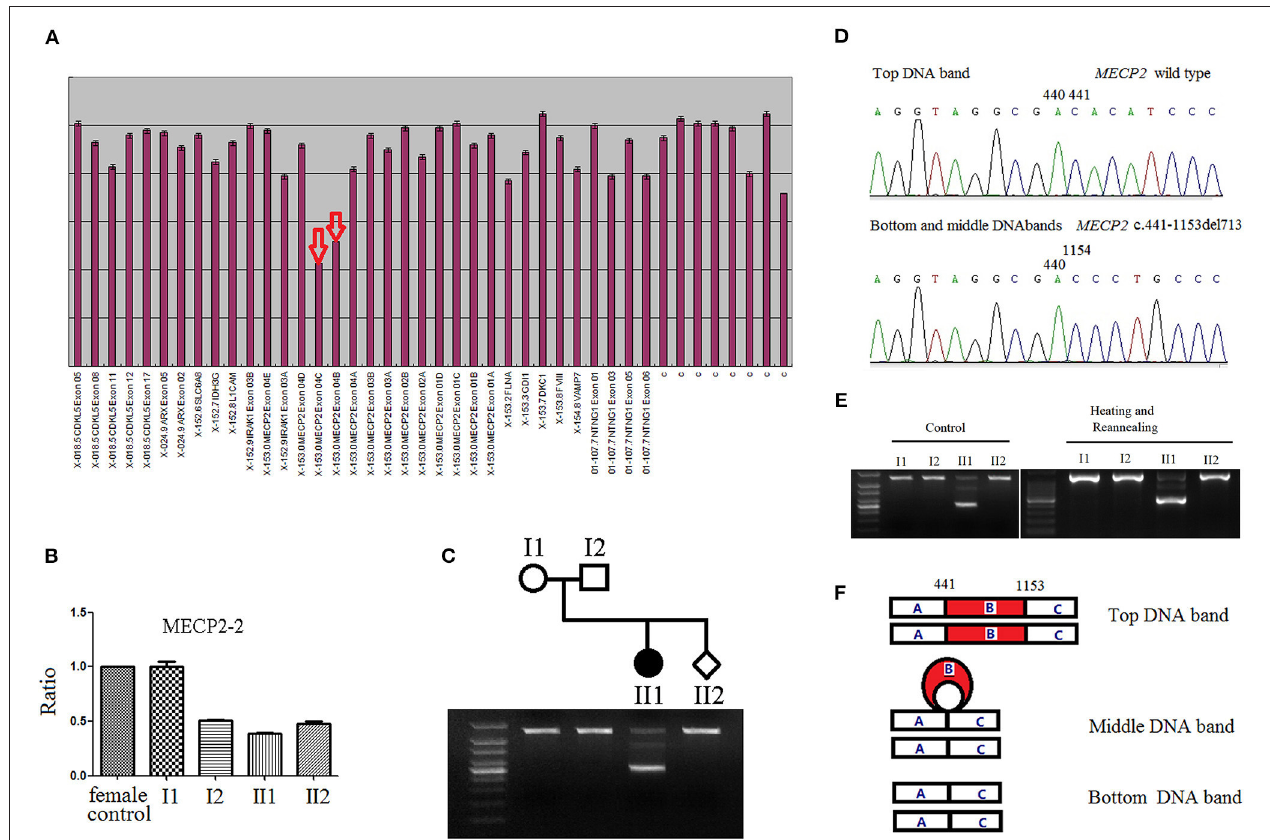
FIGURE 1 | (A) Detection of MECP2 exon alterations via multiplex ligation-dependent probe amplification (MLPA). The arrows illustrate the presumed deletions, as the area of the peaks from the female proband DNA is approximately half that of the female controls. (B) The MECP2 amplicon with MECP2-real time quantitative PCR-2 primers to narrow down the deletion breakpoints and determine the results of MLPA. MECP2 relative amount of female proband, and male fetus were half that of female control. (C) The products of long-range PCR were analyzed with 1.5% agarose gel electrophoresis. The PCR product from the proband showed three DNA bands, whereas PCR product bands of the proband’s parents and the fetus, were single. (D) Three DNA bands of long-range PCR from the proband were separately cut, T-A cloned, and finally sequenced after plasmid extraction. The sequence of top DNA band was wild type; both, bottom and middle DNA bands show 713-base pairs deletion in exon 4 (c.441_1153del713), and the single band of proband’s parents and the fetus were of the wild type. (E) There was no difference between the PCR products untreated (left) and treated with heating and reannealing (right) in electrophoresis analysis. The treated PCR products were denatured at 95 ◦ C for 3min, followed by gradual reannealing for 30min with a temperature ramp of − 1 ◦ C/min to optimize for the formation of heteroduplexes and homoduplexes. (F) Schematic diagram of three DNA bands after PCR. The top DNA band was homoduplex of wild type, the bottom DNA band was homoduplex of mutant type, the middle DNA band was heteroduplex of wild type and mutant type. Part B (red): 713-base pairs deletion in exon 4 (c.441_1153del713) of